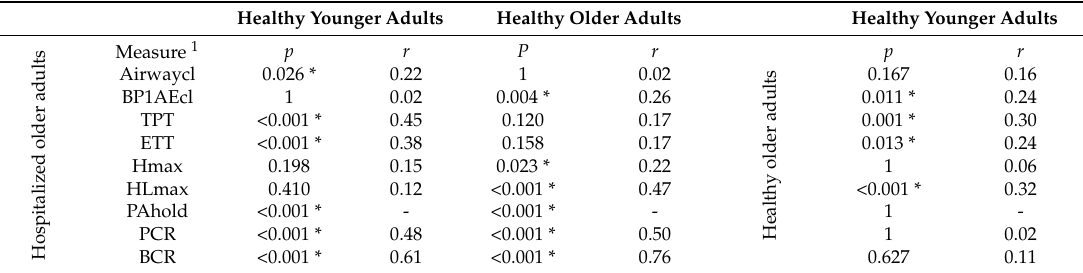
Table 5. Post-hoc comparisons between hospitalized older adults and healthy adults, and healthy older and younger